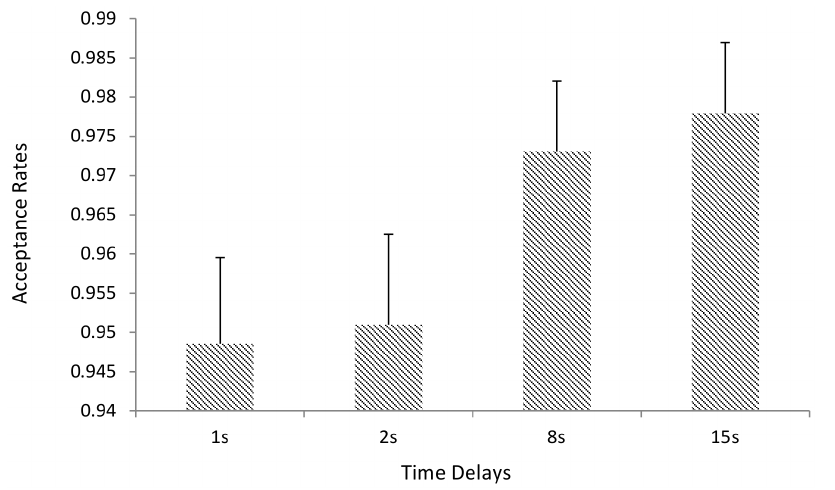
Figure 5. Average Acceptance rates for Different Time Delays for 50:50 Offers. Error bars = standard error of the mean.